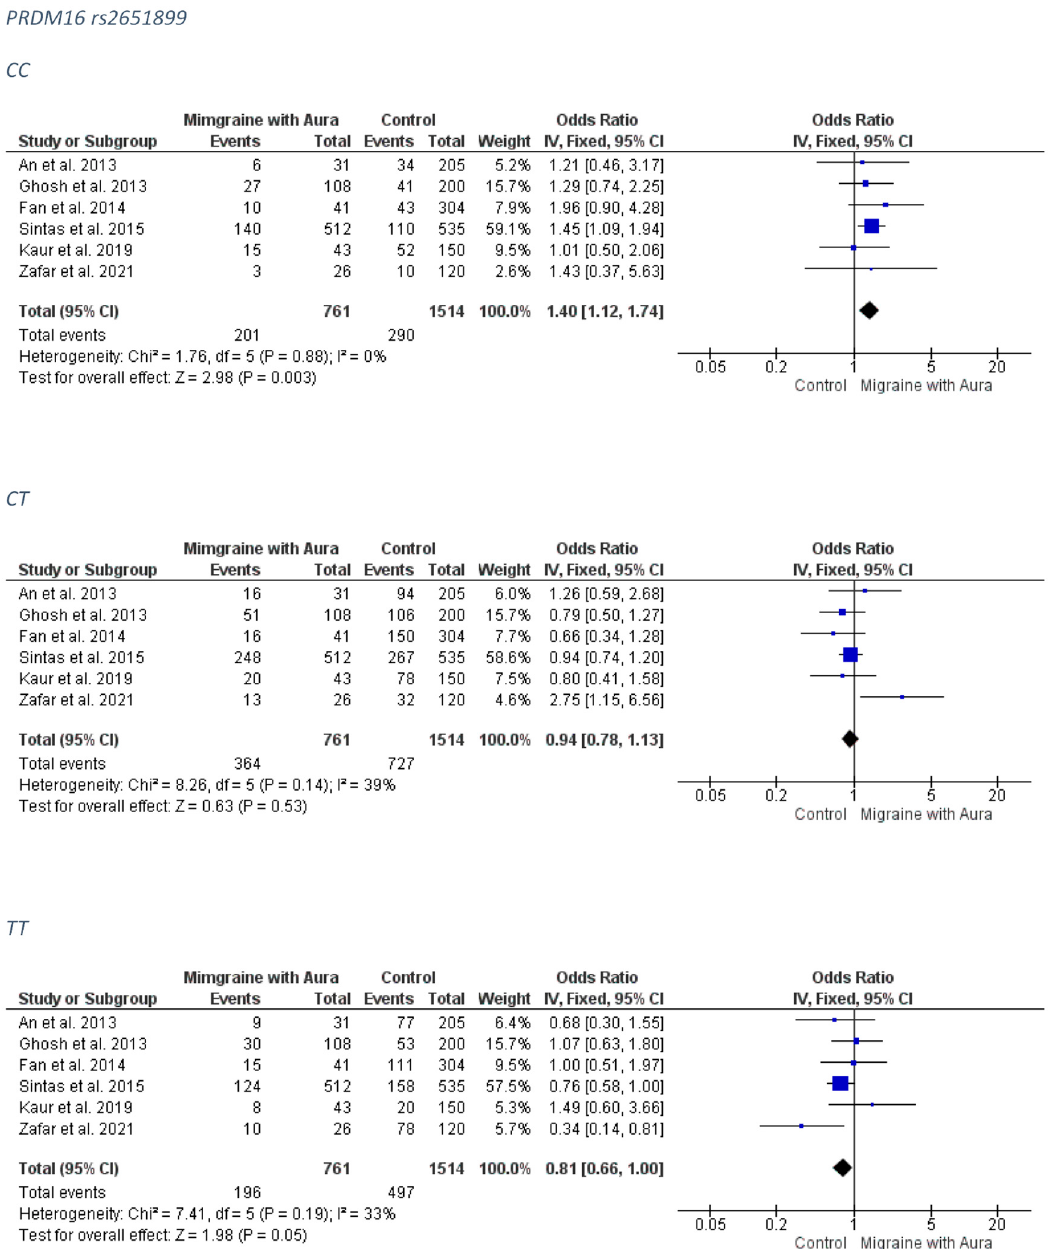
Figure 2. The forest plots presenting the results from meta-analysis of the rs2651899 and migraine with aura group.